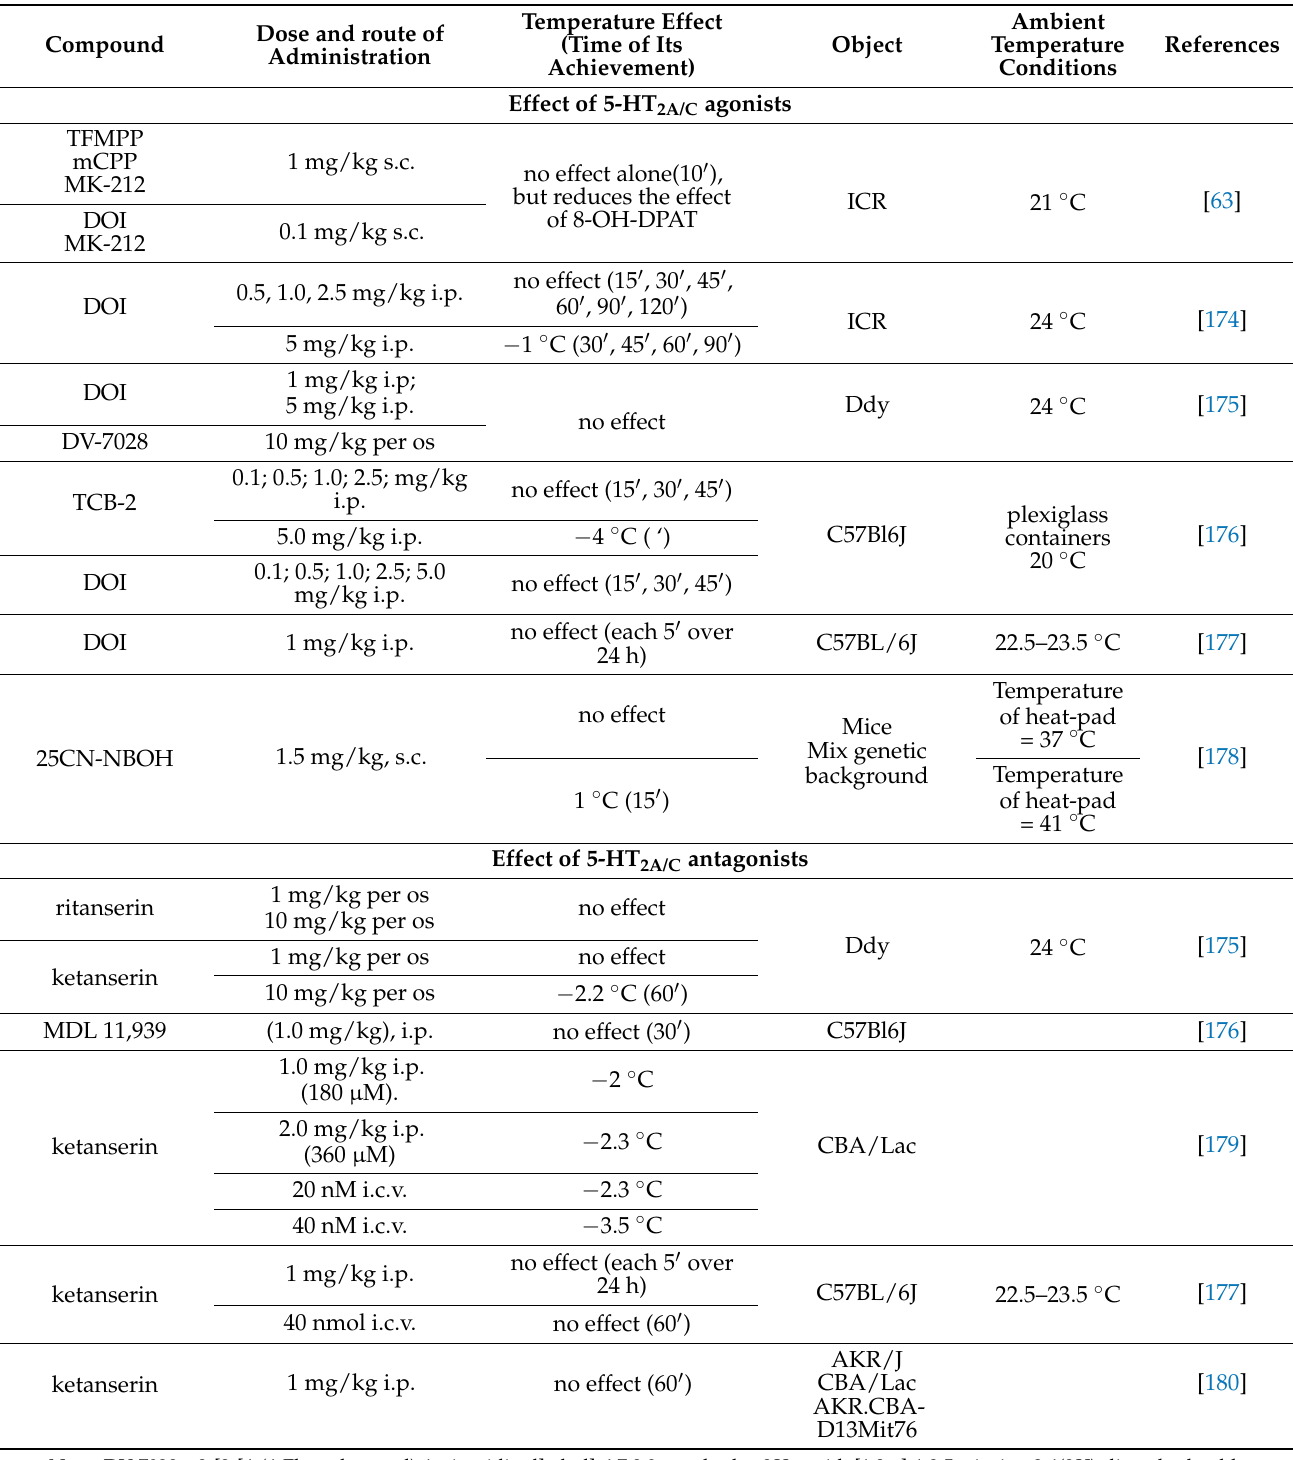
Table 5. Effect of 5-HT 2A/C agonists and antagonists on body temperature of mice.